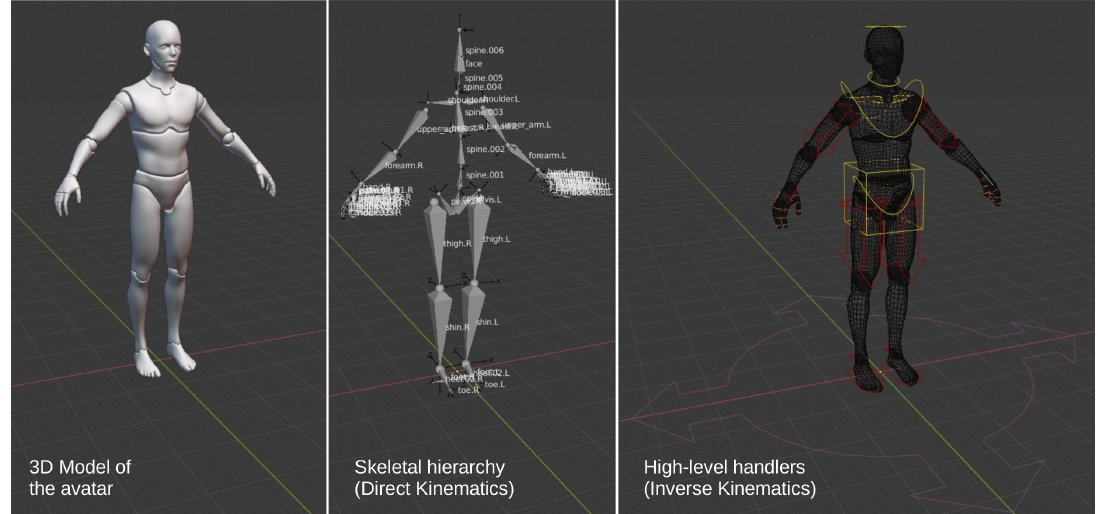
Figure 2. Definition of the 103 bones of the humanoid skeleton according to the specification of HAnim 2.0 ( Left ) avatar representation. ( Center ) definition of the kinematic chains. ( Right ) high-level reverse kinematics